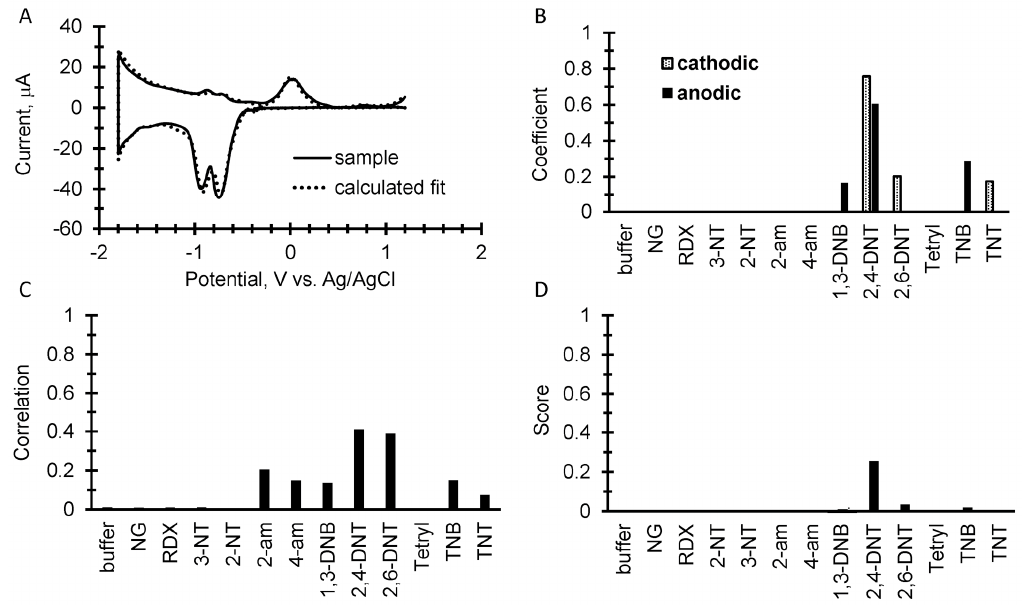
Figure 7. 10 µ g of 2,4 DNT wiped from a bench top. ( A ) An overlay of the background subtracted cyclic square wave voltammogram with the calculated fits of both the anodic and cathodic sweeps using coefficients from the explosive’s library. ( B ) A plot of the resulting coefficients from the fitting calculation for the result shown in A. ( C ) The correlation calculation comparing the measured sample to the square wave voltammetry library. ( D ) The score displayed as the product of the coefficients and correlations.